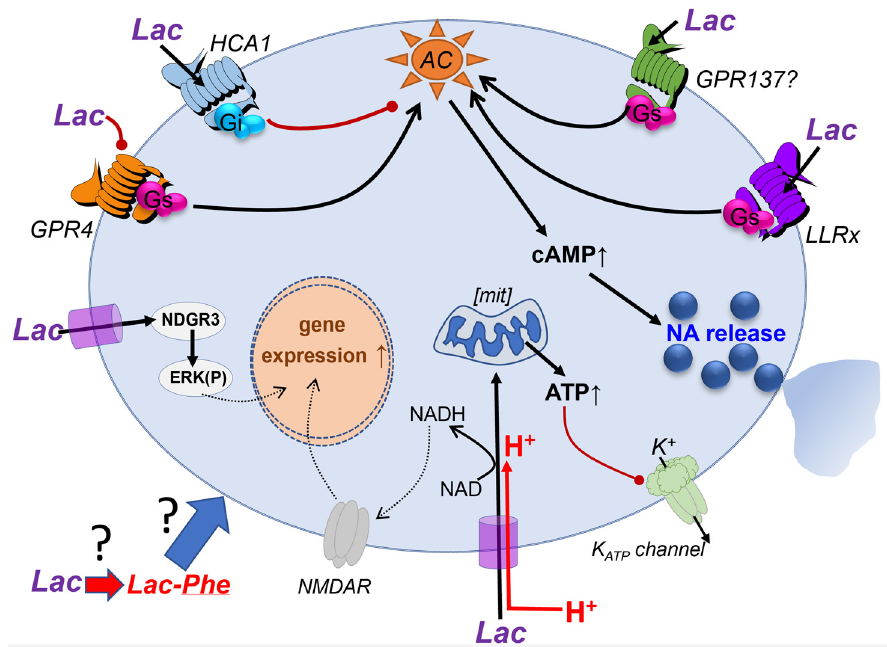
Figure 3. Summary of putative Lac receptor-mediated signaling mechanisms in brain cells. Lac transported into the cell can be metabolised and/or influence gene expression, e.g., via NMDA receptor modulation or ERK pathway activation. Increased ATP levels may inhibit KATP channel activity and decrease cell excitability. Lac may also act via surface GPCR to stimulate or inhibit neurones. The effects of acidification caused by protons co-imported via MCT require clarification. We also hypothesise that Lac can be converted into Lac-Phe in the brain, the implications of which have yet to be discovered. Black arrows—stimulatory action; red lines—inhibitory. AC—adenylate cyclase; NA—noradrenaline; NDRG3, ERK(P)—phosphorylation of extracellular signal-regulated kinases; mit—mitochondria. Modified from [48].